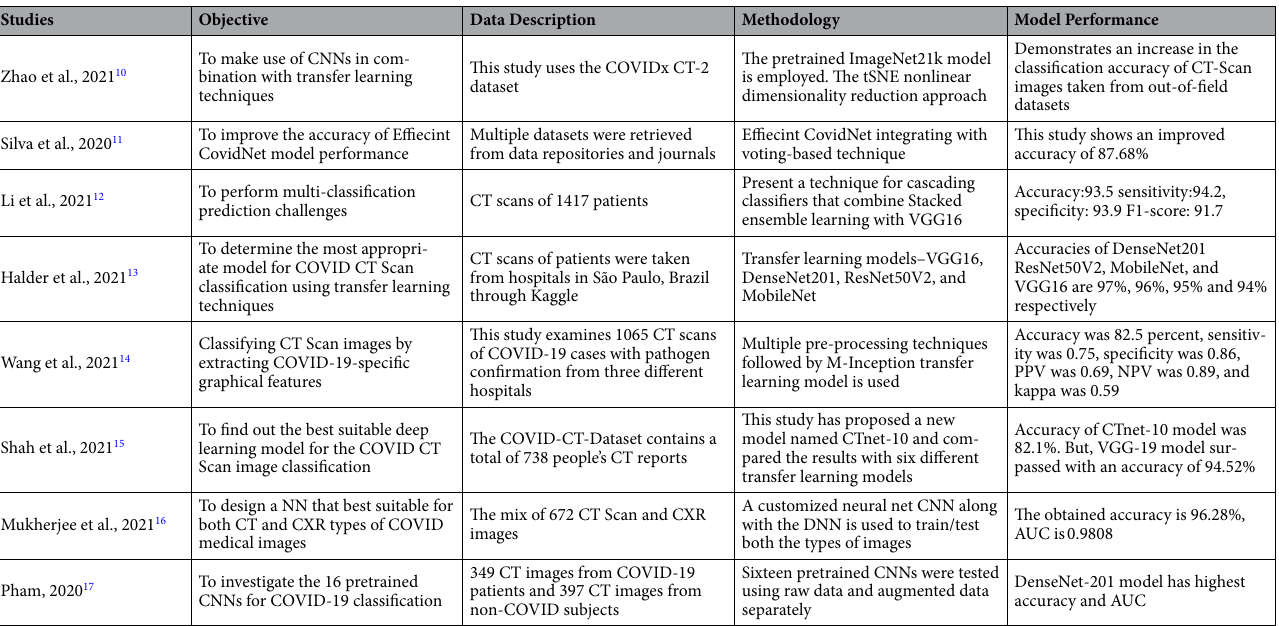
Table 1. Review on methods and quantitative results for the classification of COVID-19 CT-Scan